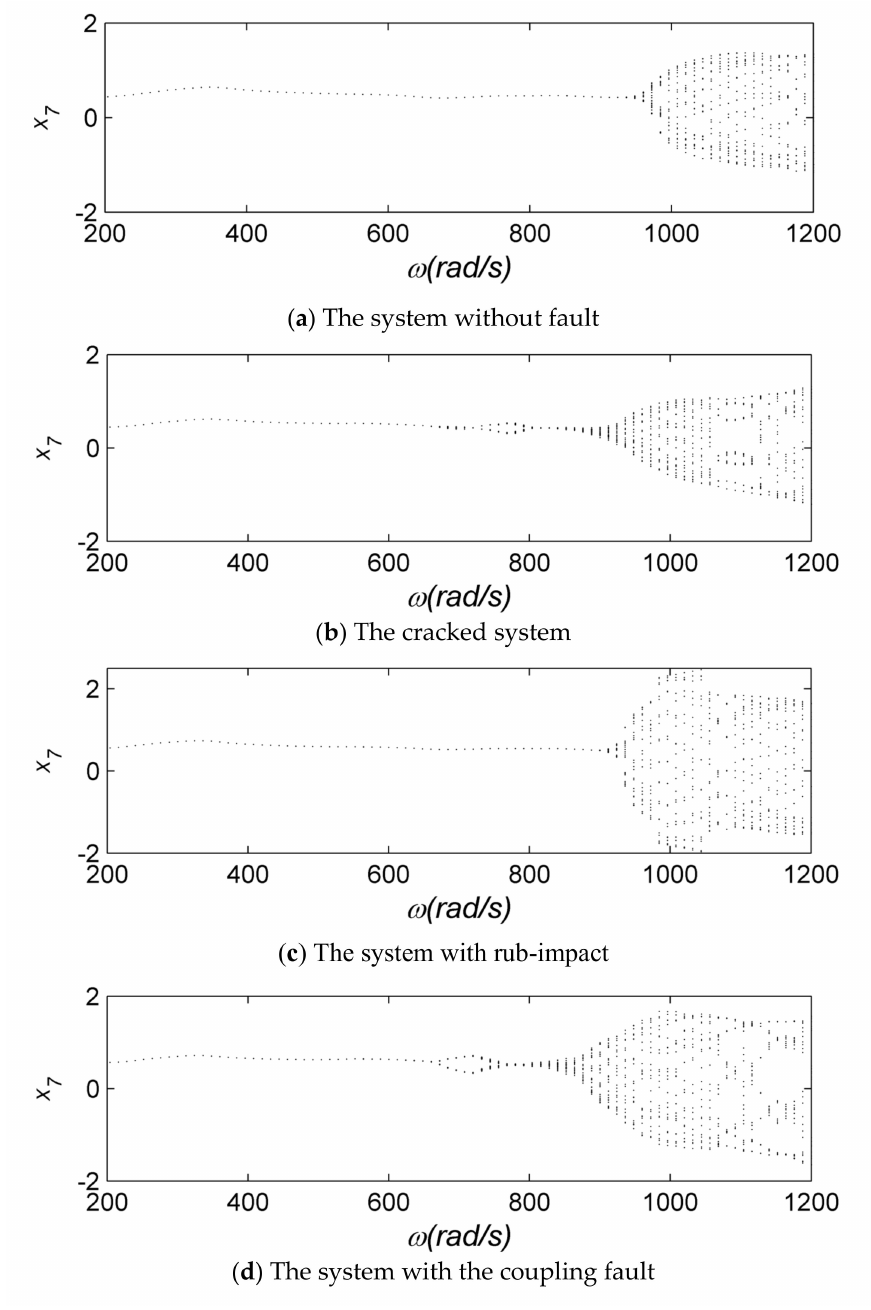
Figure 4. Bifurcation